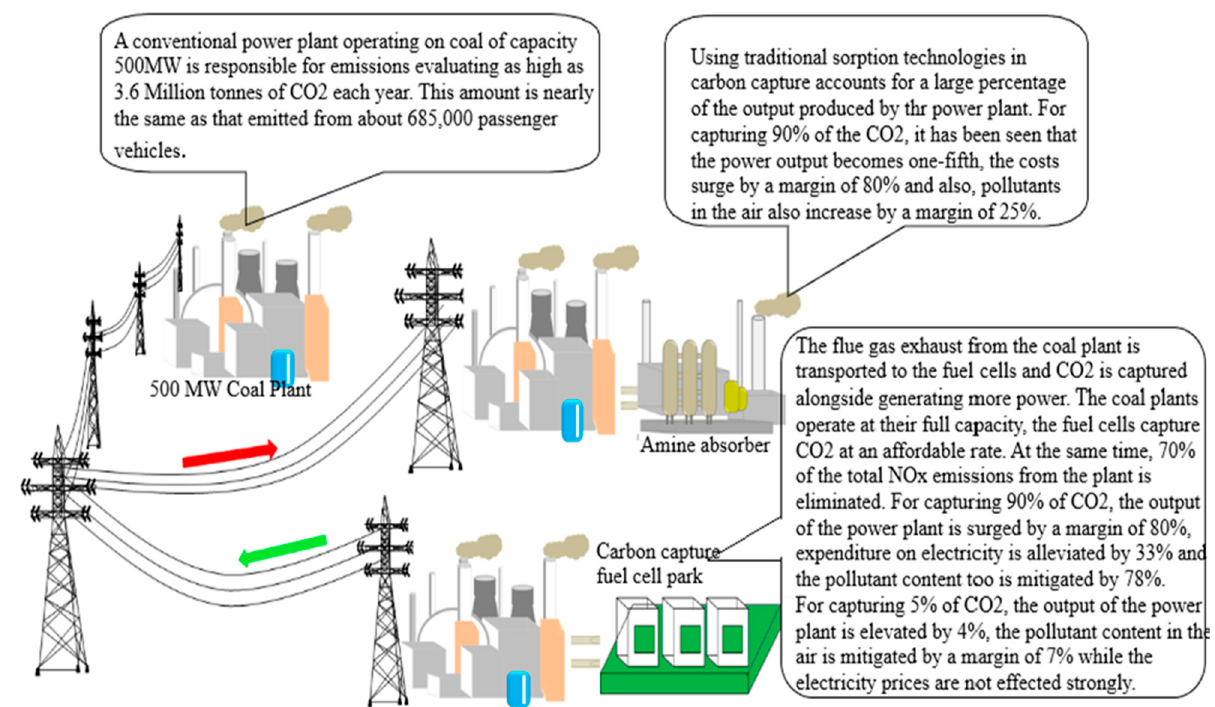
Figure 8. Advantages of a fuel cell system over conventional power generators.